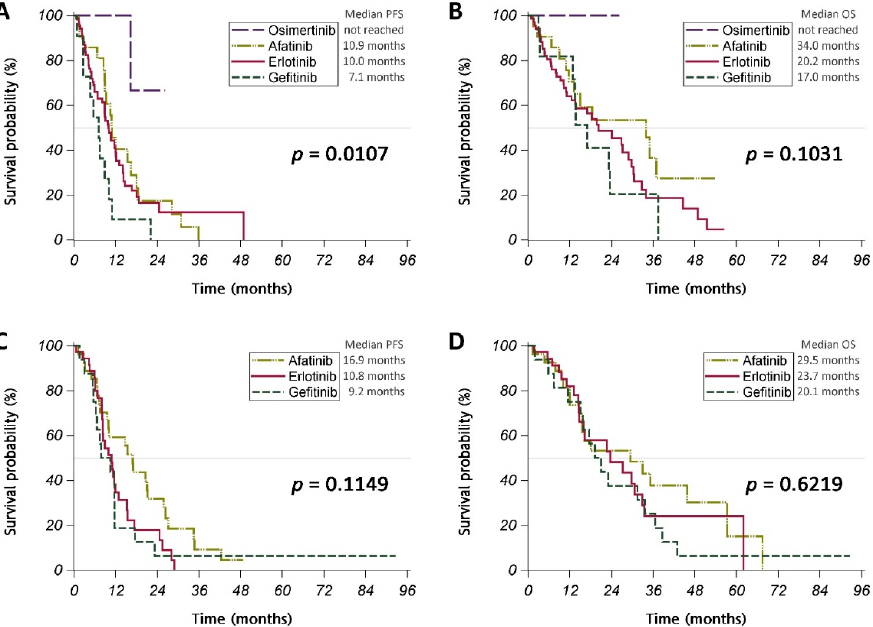
Figure A2. ( A , C ) Progression-free survival (PFS) and ( B , D ) overall survival (OS) of patients receiving different epidermal growth factor receptor tyrosine kinase inhibitors and ( A , B ) undergoing or ( C , D ) not undergoing surgery (OP) or radiotherapy (RT) for a brain tumor. Cancers 2023 , 15 , x